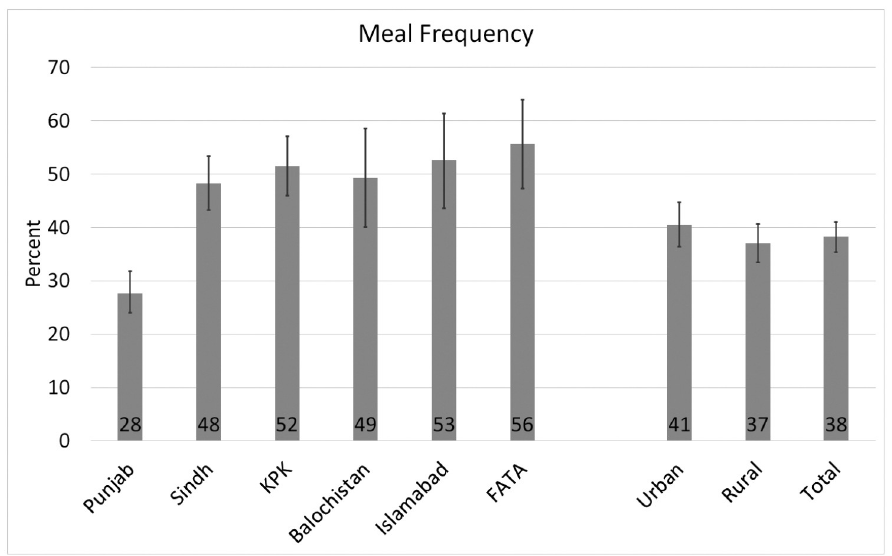
Fig 2. Prevalence of minimum meal frequency aged 6–23 months across regions and urban/rural areas in Pakistan (2017–18): 95% confidence intervals are represented by error bars. Source: Author using DHS (2017–18) data. Factors associated with minimum dietary diversity. The adjusted odds ratios from the multivariate logistic regressions for the factors associated with minimum dietary diversity compliance (95% CI) are presented (Table 3). Among individual-level characteristics, child age is a significant predictor of minimum dietary diversity. Children aged 6–11 months have two-fold, three-fold and ~4-fold higher odds of meeting minimum dietary diversity in urban areas [2.3 (1.59–3.33)], overall sample [2.96 (2.28–3.83)], and rural areas [3.97 (2.71–5.81)], respectively, as compared to the children aged 18–23 months. Children who had above average weight at birth and who took vitamin A supplements in the last six months have higher odds